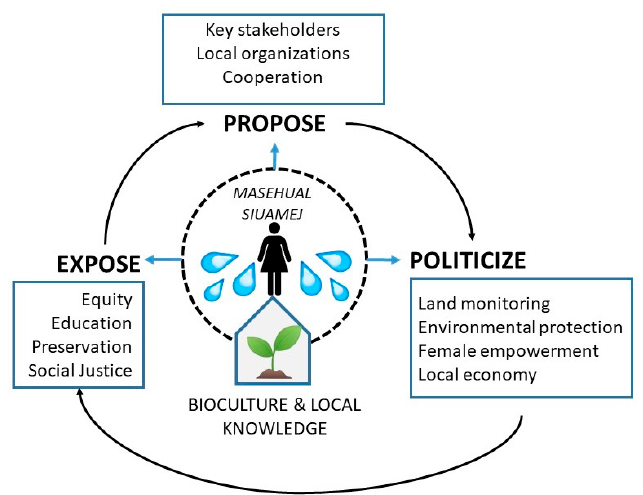
Figure 2. Transformation of gender roles through empowerment in the context of Masehual. Source: Schumacher (2020).